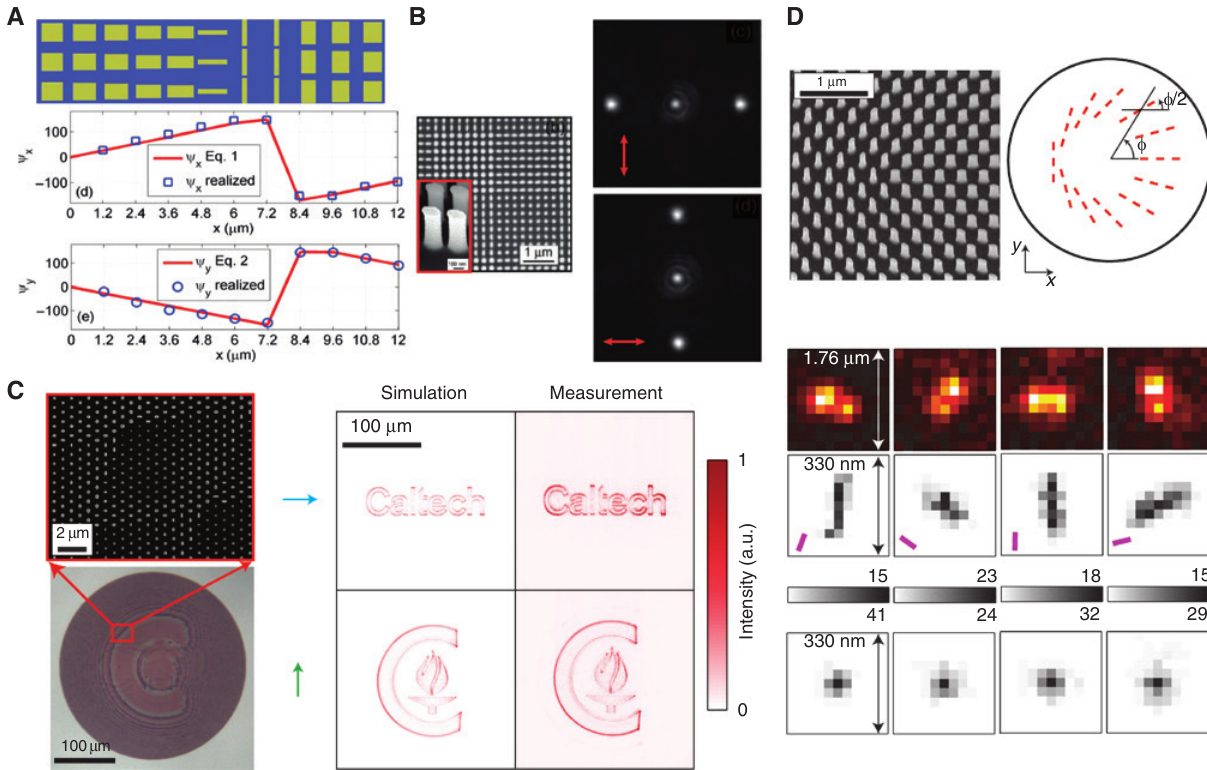
Figure 7: Wavefront shaping with polarization and phase control. (A) A reflective grating designed to deflect x - and y -polarized light to different deflection angles. A schematic of one period of the device is shown on the top. Desired and simulated phase profiles at an operation wavelength of 8.06 μ m under x and y polarizations are shown on the bottom, respectively [157]. (B) A 2D grating with the ability to diffract x -polarized light vertically and y -polarized light horizontally is demonstrated. A scanning electron micrograph of the fabricated grating is shown on the left. Far-field intensities of the grating under x - and y -polarized light are shown on the right. The grating is measured under 976-nm illumination [231]. (C) A polarization switchable hologram generates two different images under horizontal and vertical polarizations [13]. Optical (bottom) and scanning electron micrograph (top) of the device are shown on the left. Simulated and measured intensity profiles under different linear polarizations are shown on the right. (D) A scanning electron micrograph of a portion of the device that converts azimuthally polarized light into y -polarized light is shown on the left. The metasurface functions as spatially varying half-wave plates, with the principal axis orientation indicated by the red dashed lines (top, right). Images of four molecules (top row) and apparent displacement of those molecules through a z-scan with (bottom row) and without (middle row) the metasurface mask